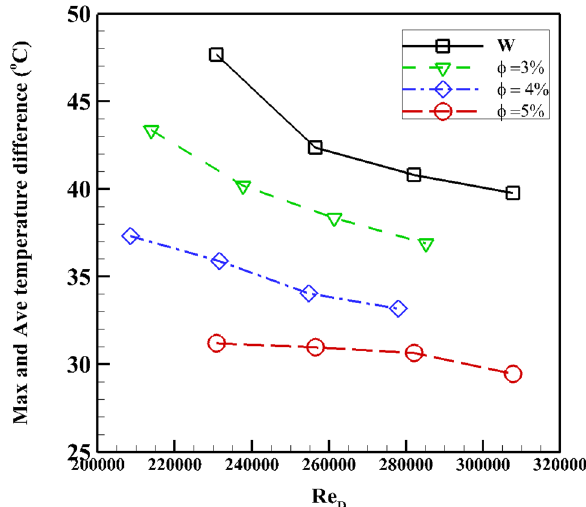
Fig. 28 Difference between maximum and averaged temperature on WCP hot-side at constanct concentration vs Re